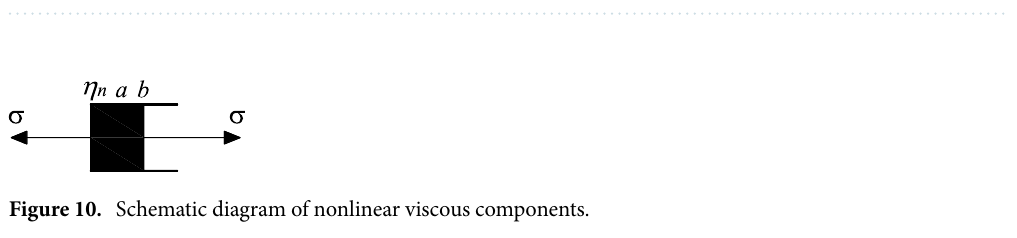
Figure 9. Schematic diagram of the structural plane damage mechanism.